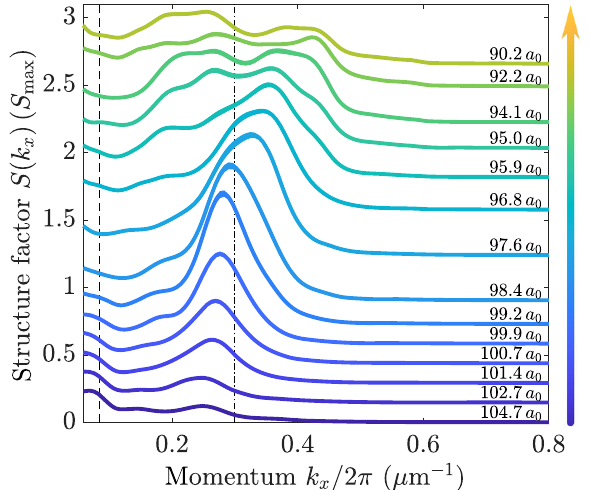
FIG. 2. Experimentally determined structure factor in units of S ¼ 260 for different scattering lengths a s . The dashed line on max = 2 π ≃ 0 . 08 μ m − 1 the left indicates the smallest momentum k min available due to the finite size of the system along the x direction. The dash-dotted line at k x = 2 π ≃ 0 . 3 μ m − 1 roughly indicates the inverse droplet spacing in the droplet regime, which coincides with the roton momentum at the transition point. Errors are indicated as increased thickness of the lines and are obtained by the bootstrapping method [45,54]. For illustration purposes, the lines for smaller a s are shifted up. The momentum axis is sampled with a spacing of Δ k x = 2 π ≃ 0 . 007 μ m − 1 . The colored arrow indicates the direction toward lower scattering lengths, passing from BEC to supersolid to isolated droplet